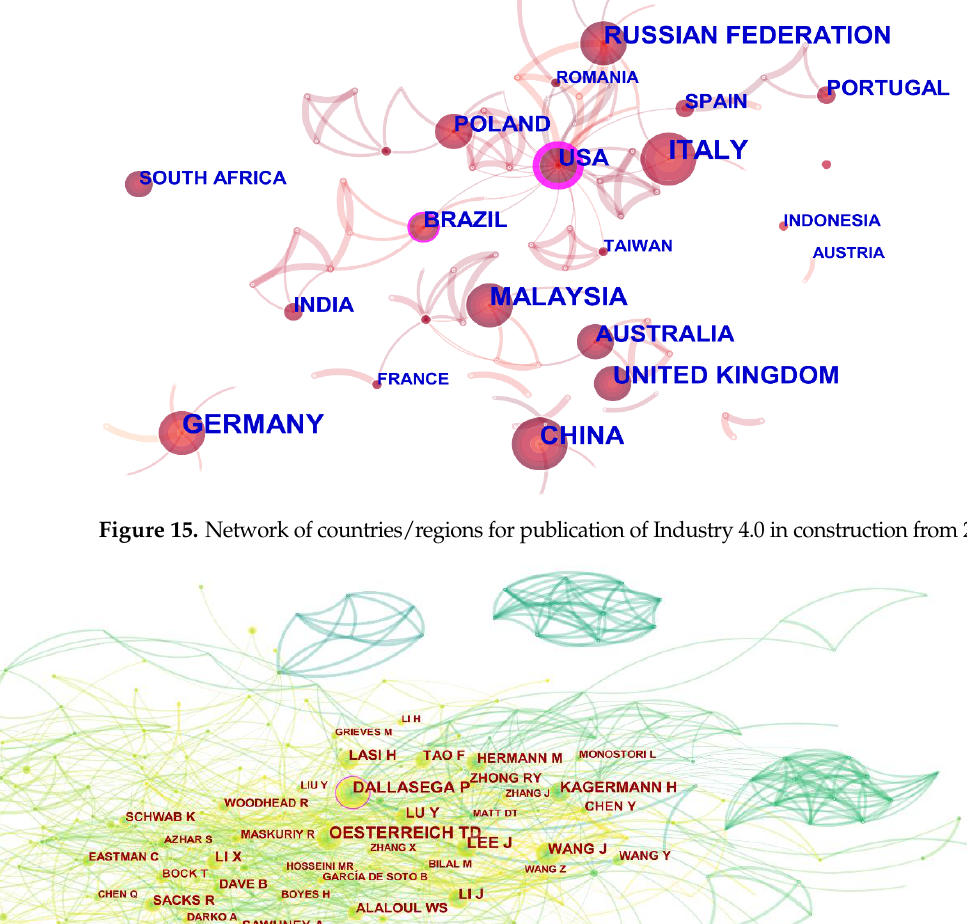
Figure 17. Abstract clustering network map of co-citations for Industry 4.0 in construction. Table 9. Co-citation clusters of Industry 4.0 in construction from 2006 to 2022. Cluster ID